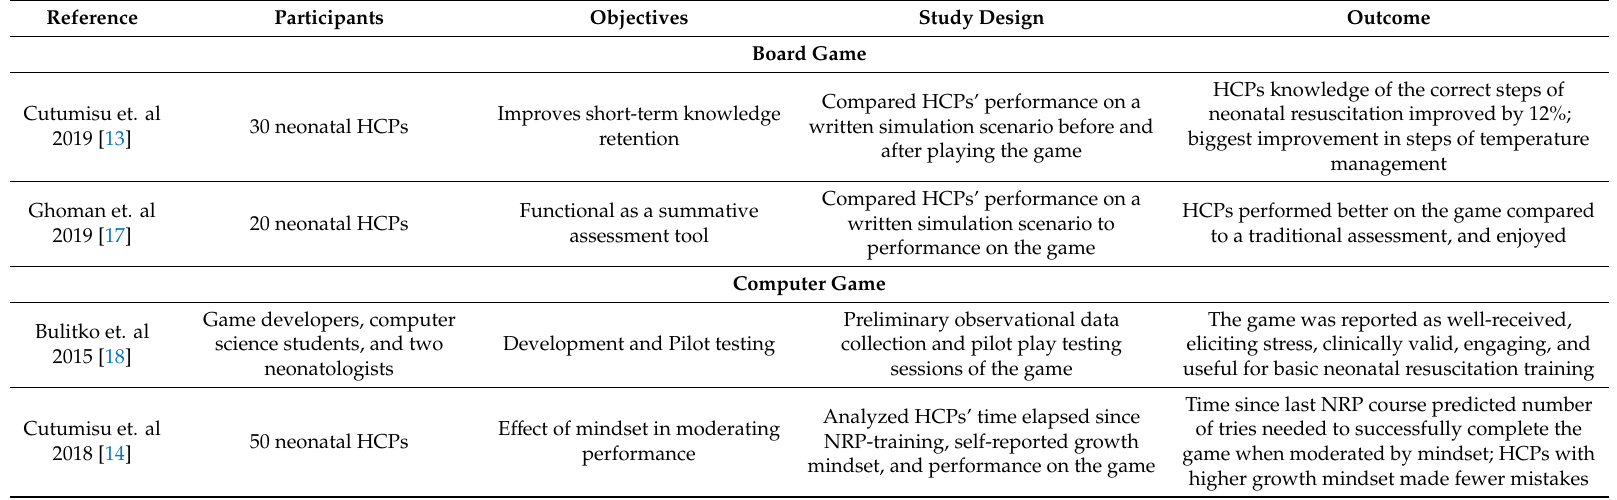
Table 1. Summary of the RETAIN board game and computer game. Healthcare professional is abbreviated as HCP. Neonatal resuscitation program is abbreviated as